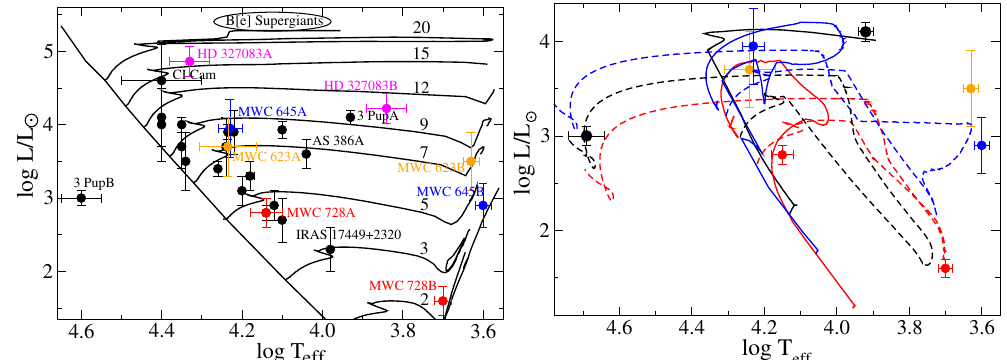
Figure 5. Hertzsprung–Russell diagram for FSCMa objects with known parameters. Left panel: Recently studied objects are marked with their IDs (“A” stands for the brighter primary component, while “B” stands for the fainter secondary component). Solid lines: the zero-age main-sequence and evolutionary tracks for single rotating stars [23] with initial masses in solar units indicated. Right panel: Positions of 4 confirmed double-lined FSCMa-type binaries shown by circles of different colors (same as those in the left panel): 3Pup (black), MWC728 (red), MWC645 (blue), and MWC623 (orange). Evolutionary tracks of interacting binaries from [24] are shown by the same colors as those of the objects, whose positions are explained by the models. Solid lines show tracks of gainer stars and dashed lines show tracks of donor stars. Initial masses of the shown tracks are as follows: 6.0 M (cid:12) + 3.6 M (cid:12) —black lines; 5.0 M (cid:12) + 2.0 M (cid:12) —red lines; 7.0 M (cid:12) + 2.8 M (cid:12) —blue lines.